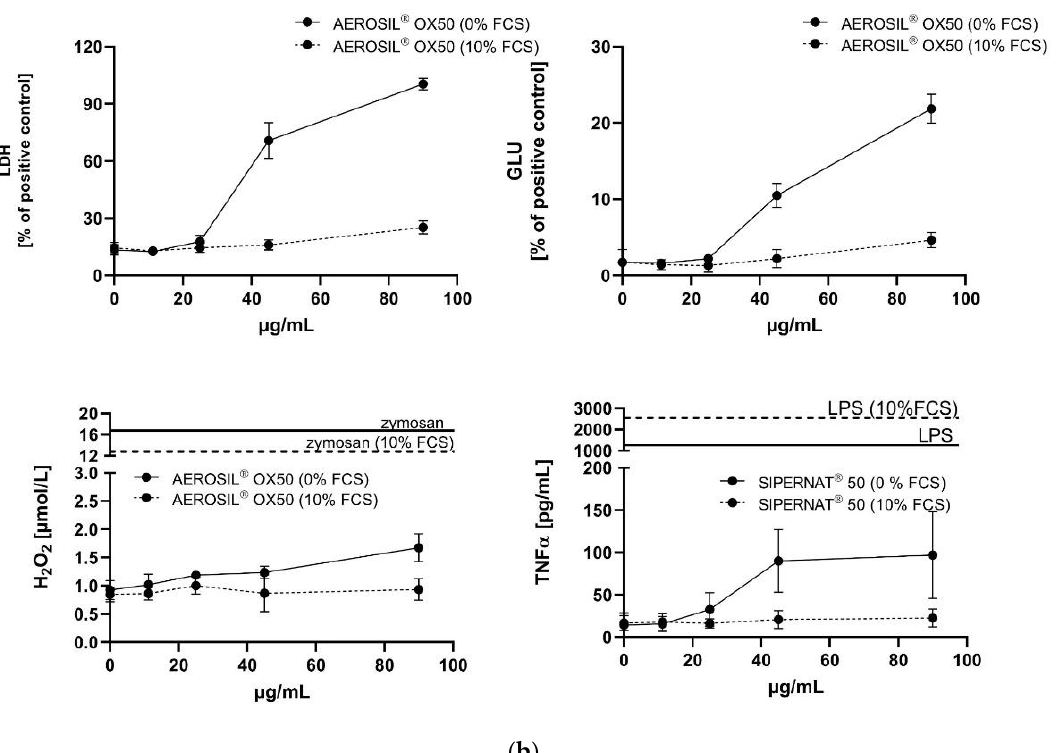
Figure 2. In vitro response of NR8383 alveolar macrophages to AEROSIL ® 380 F and to AEROSIL ® OX50 in the absence or in the presence of 10% FCS (dashed lines). Lactate dehydrogenase activity (LDH), glucuronidase activity (GLU), H 2 O 2 concentration, and tumour necrosis factor alpha (TNFα) were measured in the supernatant from NR8383 cells exposed to AEROSIL ® 380 F ( a ) or AEROSIL ® OX50 ( b ). Effects of zymosan and lipopolysaccharide (LPS) on the formation of H 2 O 2 and TNFα, respectively, are indicated by vertical lines.